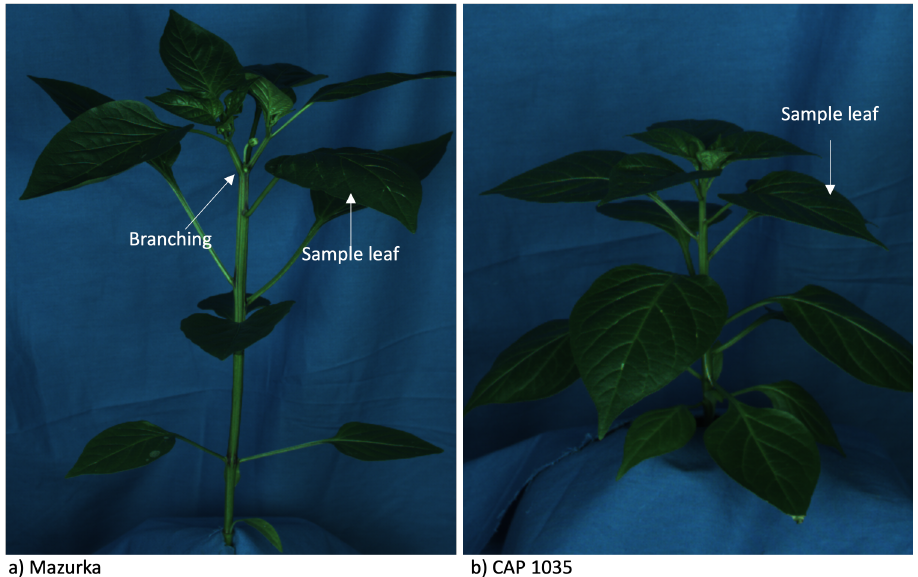
Figure A1. Position of the harvested leaf in Mazurka (a) and CAP1035 (b). Leaves beneath the first branching (seen from the tip of the plant) were harvested in both species. Indicated are the leaf and for Mazurka as well the branching point as visible in the photo.